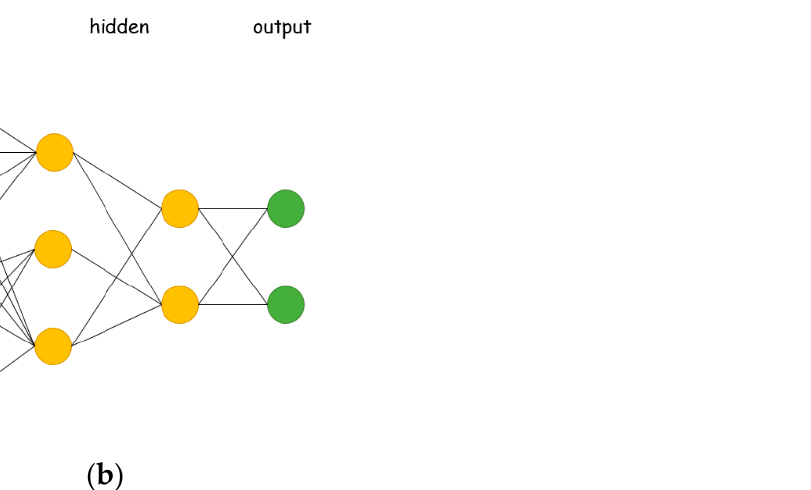
Figure 7. Representative artificial neural networks (ANNs): ( a ) An NN is fully connected; ( b ) An NN considers dropout—a hyperparameter whose value is specified and used to control the learning process of an NN—that can prevent overfitting [46] (another way used to prevent overfitting is early stopping).